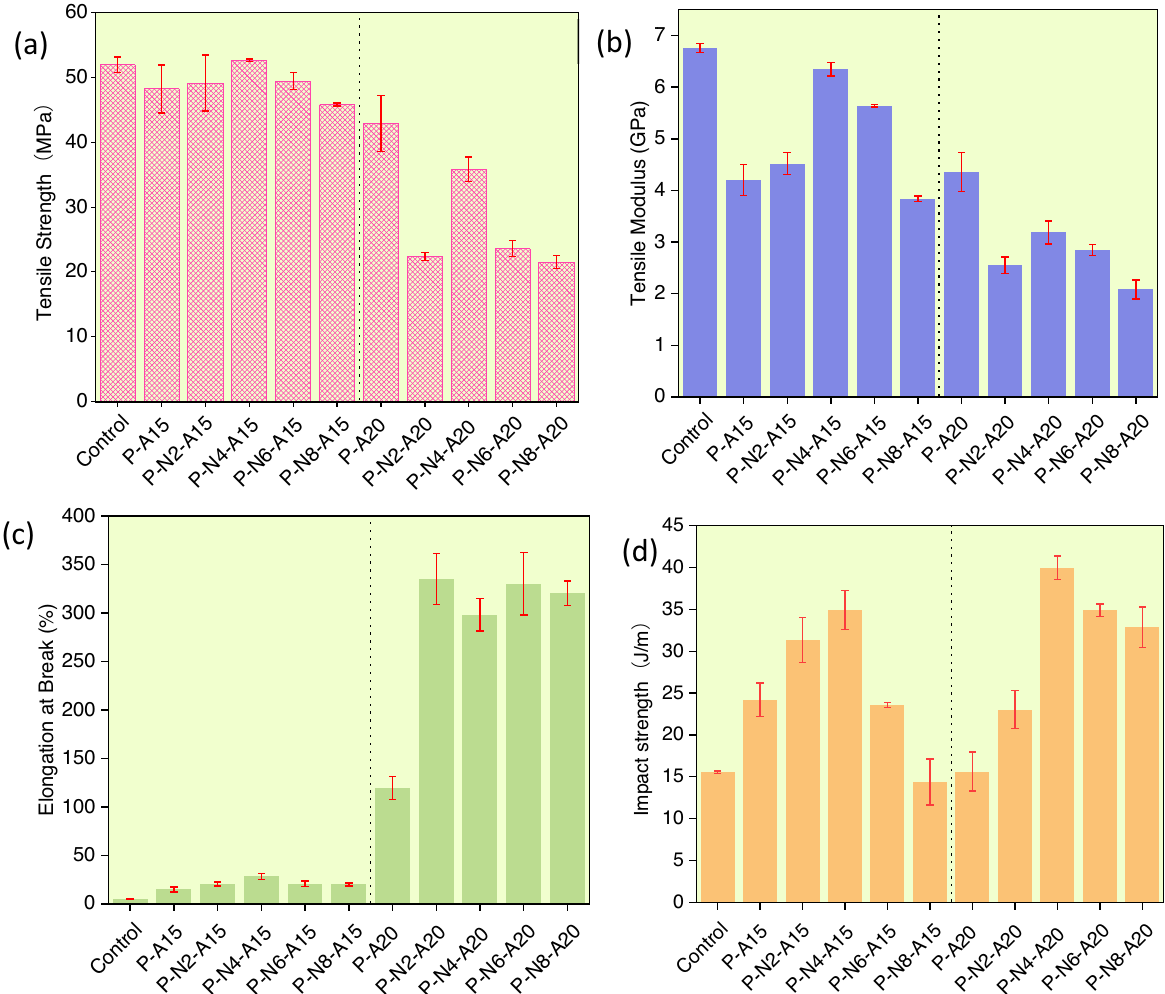
Figure 2: Tensile properties of PLA/NFC composites and notched Izod impact property of PLA/NFC composites: ( a ) tensile strength, ( b ) tensile modulus, ( c ) elongation at break, ( d ) impact